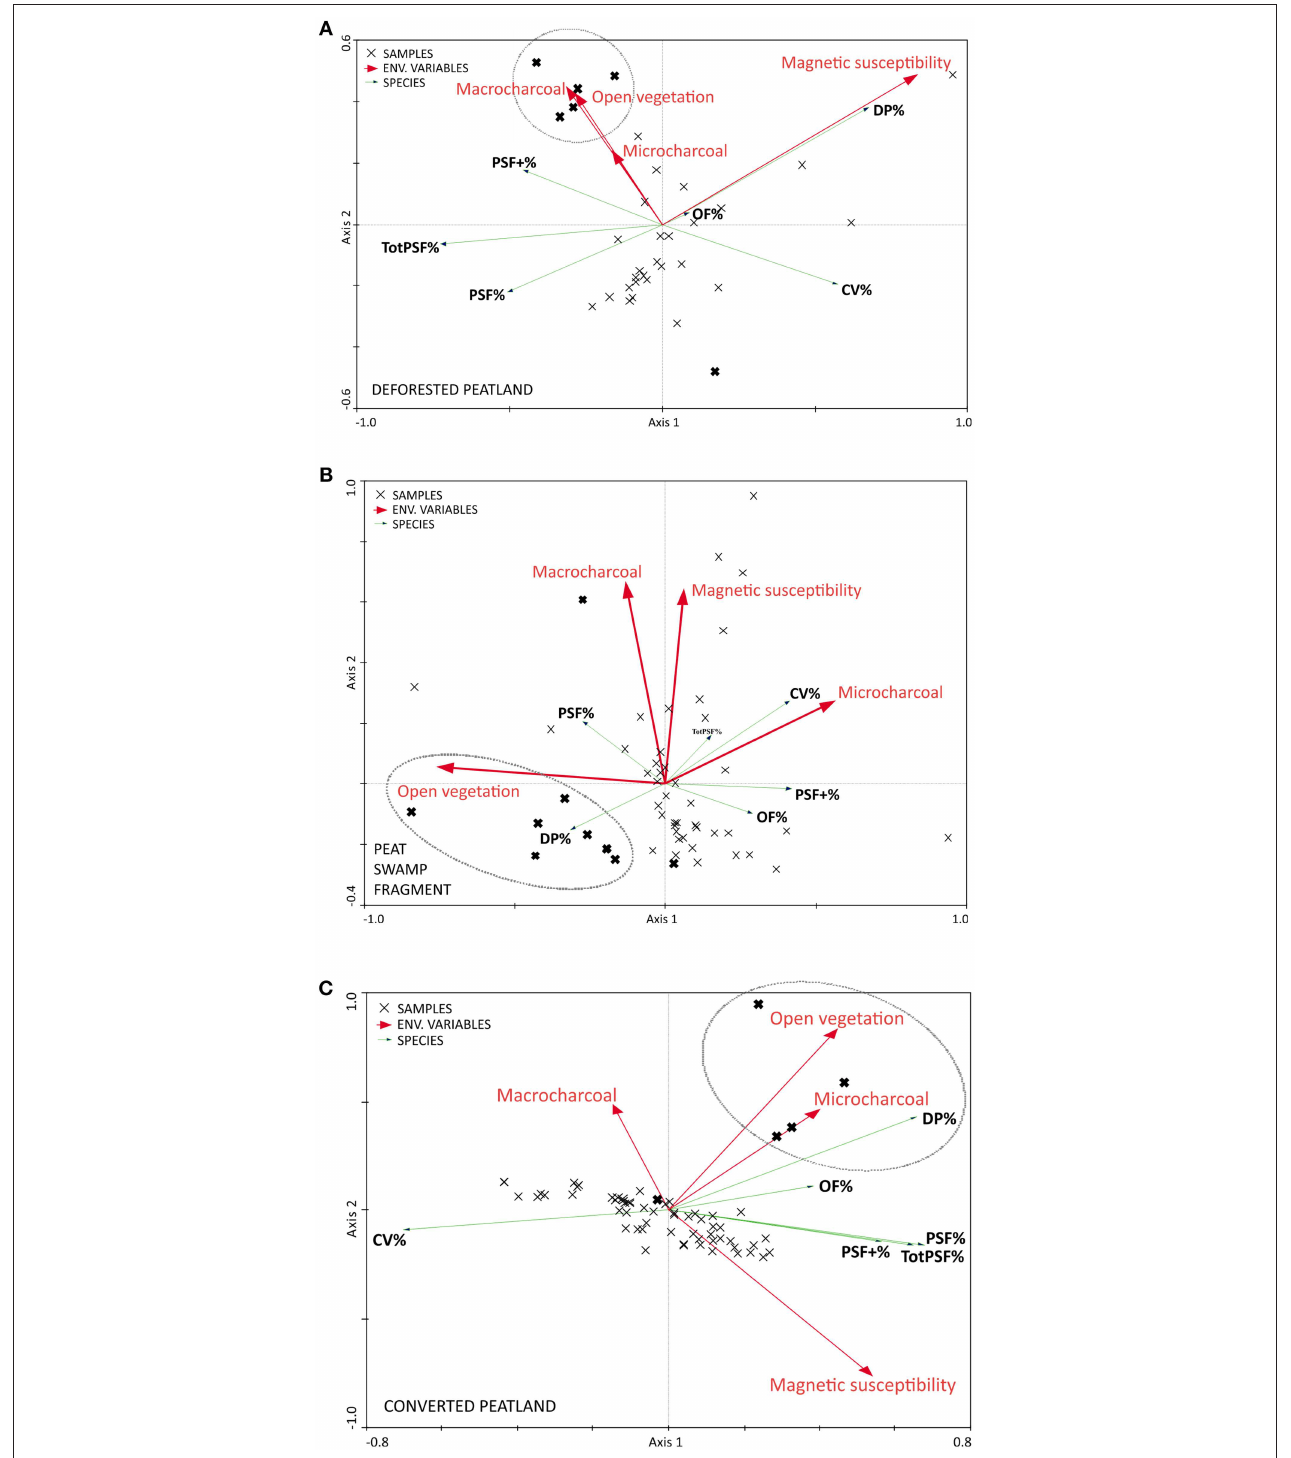
FIGURE 4 | PCA Ordination diagrams for coring sites (A) Deforested Peatland, (B) Peat Swamp Fragment, and (C) Converted Peatland, showing the relationships between the recorded environmental variables (i.e., macrocharcoal, microcharcoal, magnetic susceptibility, and open vegetation), and temporal changes in (i) internal PSF dynamics: mature (PSF%), and pioneer PSF taxa (PSF + %), and (ii) external landscape dynamics: the ecological groups comprising total PSF (TotPSF%), degraded peat (DP%), other forest (OF%), and coastal vegetation (CV%). In (A) , the 1st axis of the ordination explains 33.3% of the variance in the distribution of the ecological groups and the 2nd axis, 4.4%; with the inclusion of environmental variables, this percentage variance accounted for by the 1st and 2nd axes becomes